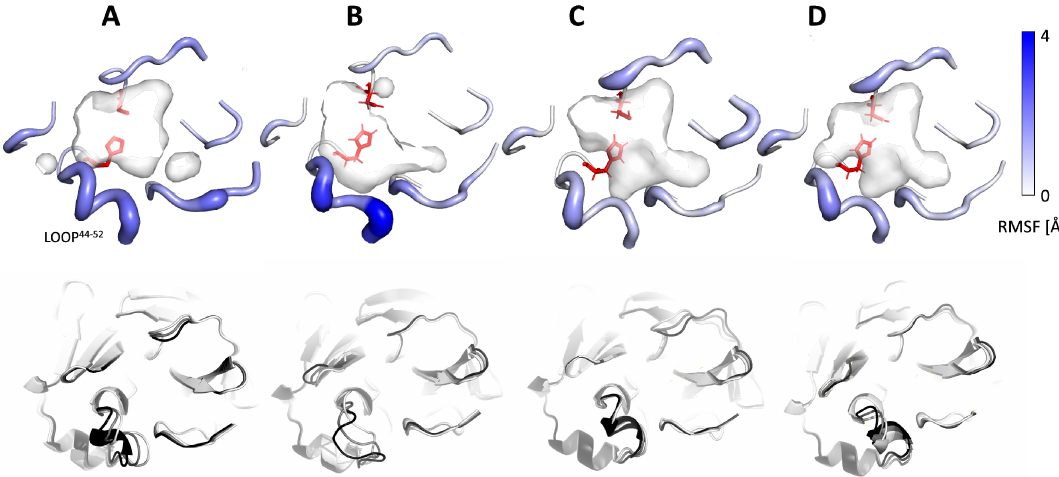
Figure 3. Flexibility of loops surrounding the entrance to the binding cavity of ( A ) SARS-CoV-2 Mpro, ( B ) SARS-CoV Mpro, ( C ) SARS-CoV Mpro N3 , and ( D ) SARS-CoV Mpro N3 . For the picture clarity, only residues creating loops were shown. Upper row: RMSF data. The active site residues are shown as red sticks, and the A46S replacement between SARS-CoV and SARS-CoV-2 main proteases is shown as light blue sticks. The width and colour of the shown residues reflect the level of loop flexibility. The wider and darker residues are more flexible. Lower row: the results of normal mode analysis as a superposition of active site surroundings; structures are coloured white—initial conformation, black—final conformation, gray—transient conformation.